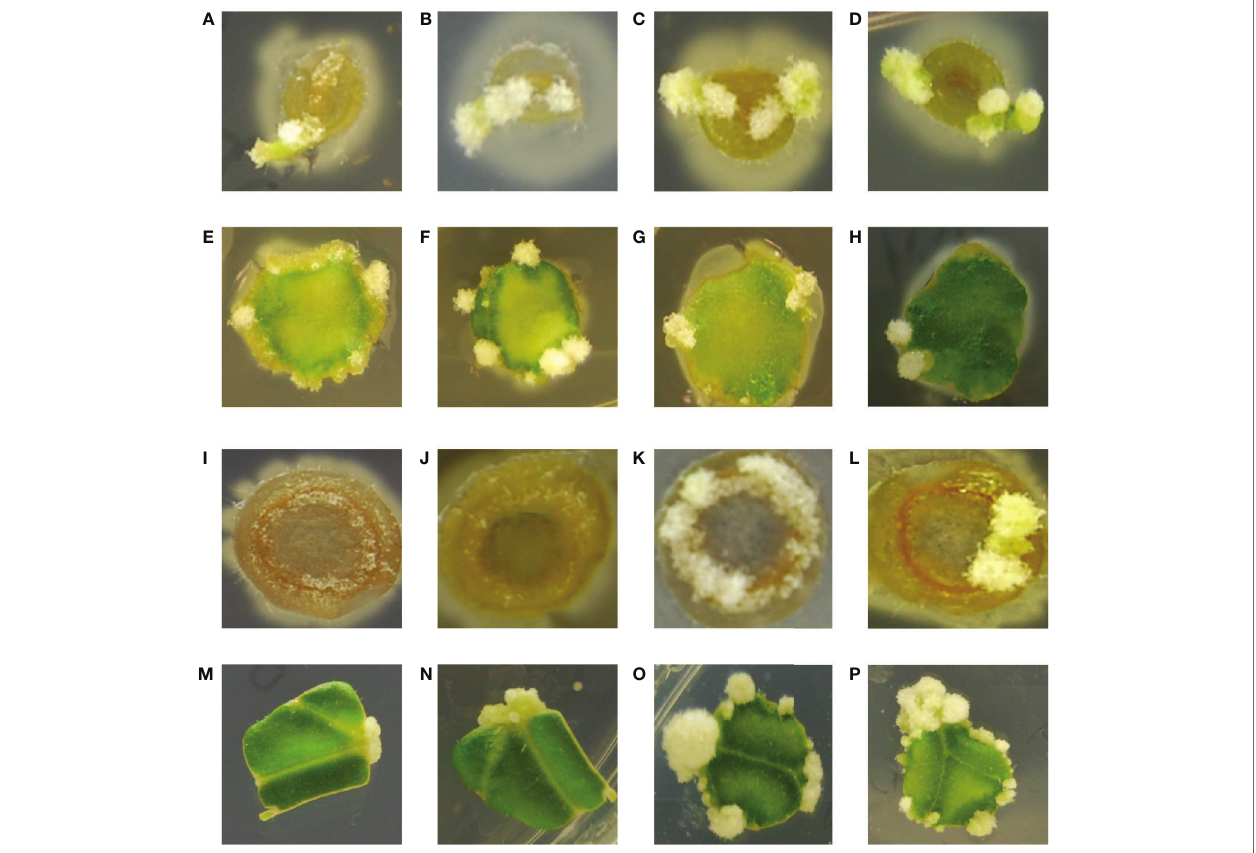
FIGURE 7 | Crown gall tumor induction on tobacco explants. Using mature plants started out in tobacco midrib explants were co-cultivated with YHL320 s+ on glucose plates (A) , and glycerol plates (B) , or with A348 wt on glucose plates (C) and glycerol plates (D) ; tobacco leaf explants with YHL320 s+ on glucose plates (E) and glycerol plates (F) , or with A348 wt on glucose plates (G) and glycerol plates (H) ; tobacco stem explants with YHL320 s+ on glucose plates (I) and glycerol plates (J) , or with A348 wt on glucose plates (K) and glycerol plates (L) for 51 days on 0.5X MS plates. Additionally, tobacco leaf explants are shown co-cultivated with A348 wt for 20 days (M) , 34 days (N) , or 78 days (O, P) . Representative photos are shown and quanti fi cation of tumor induction rate is found in Table 5